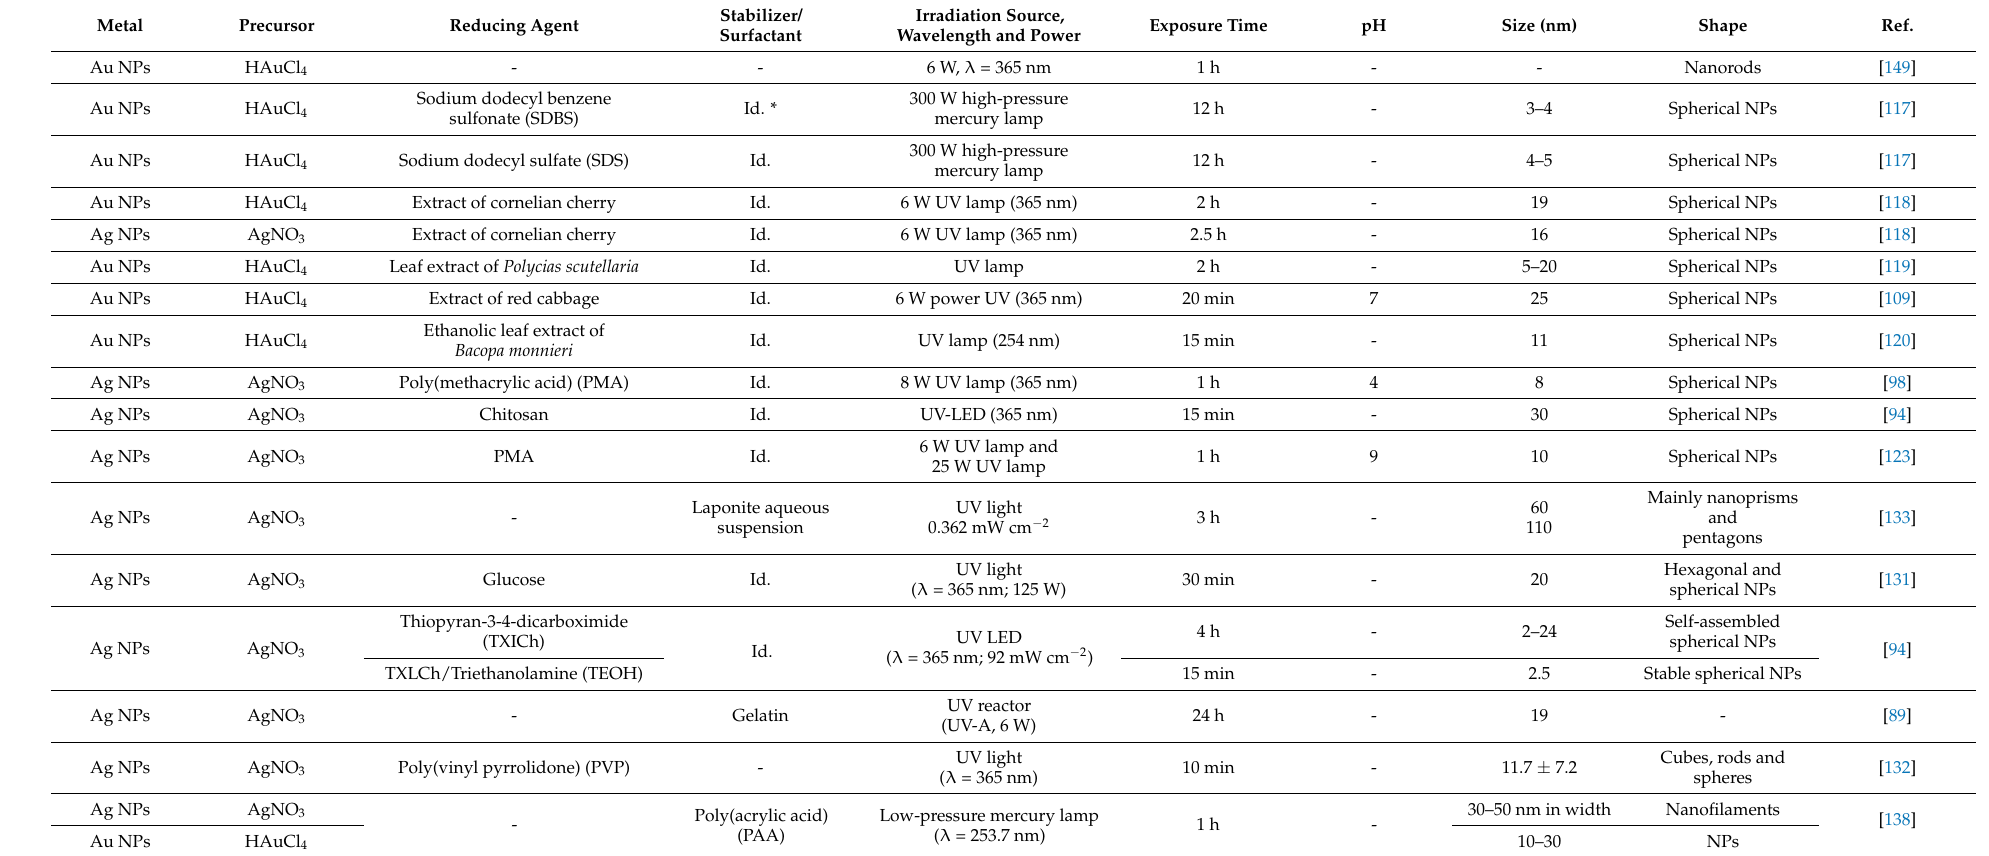
Table 1. UV-driven photochemical synthesis of Au NPs and Ag